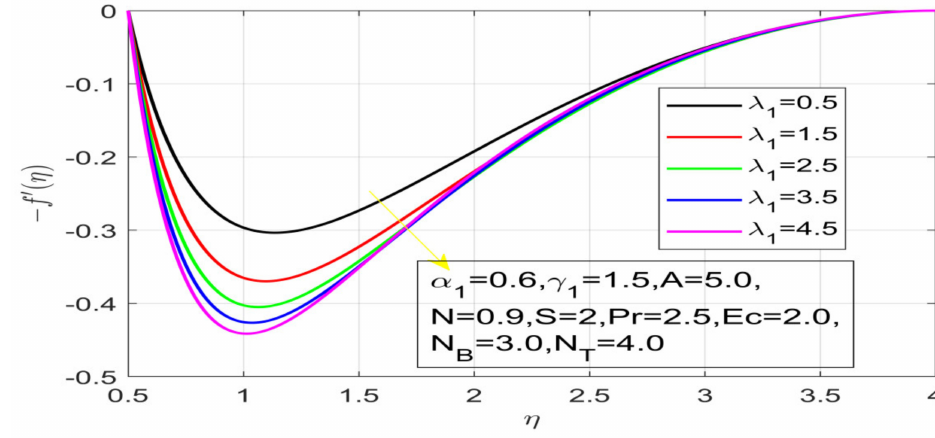
Figure 5. Influence of λ _1 on the velocity profile.